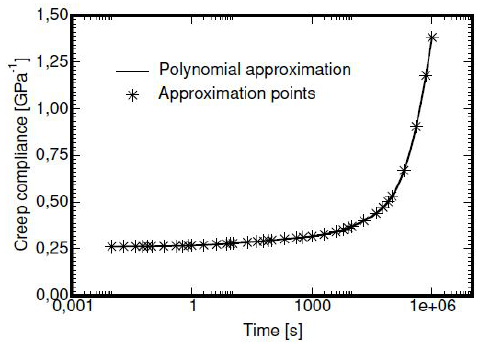
Figure 4. Eyring plot.